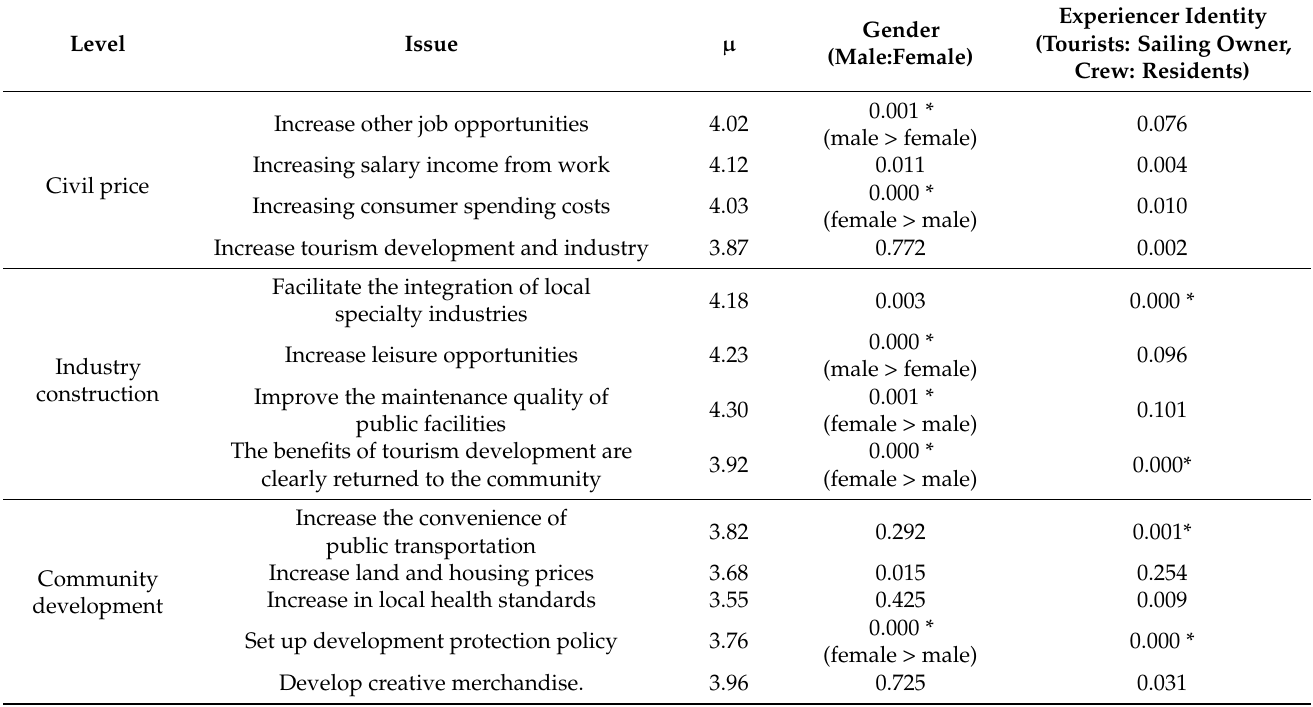
Table 4. Perception analysis of the impact on village economic